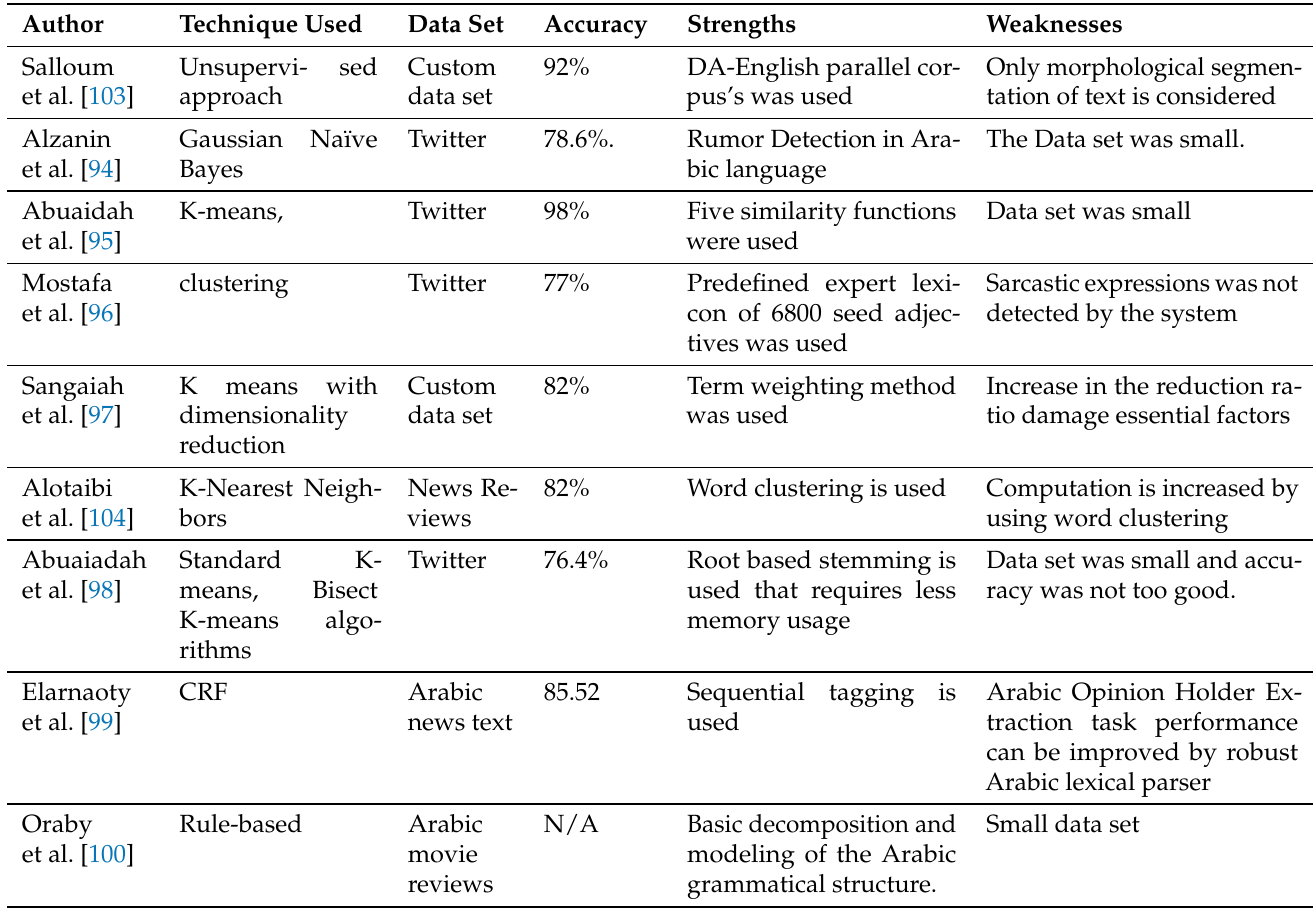
Table 3. Comparison of Unsupervised techniques used for Arabic text